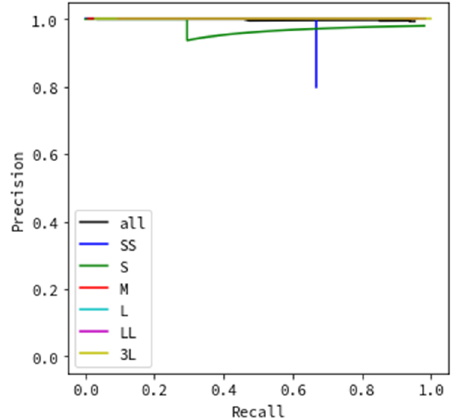
Figure 9. Detection precision by flying object size (not including categorization).